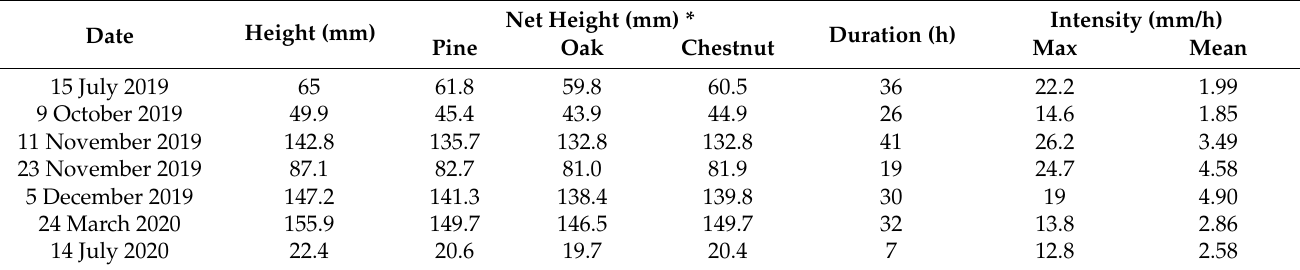
Table 1. Main hydrological variables of rainfall events monitored at the experimental sites (Samo, Calabria, Southern Italy). Height